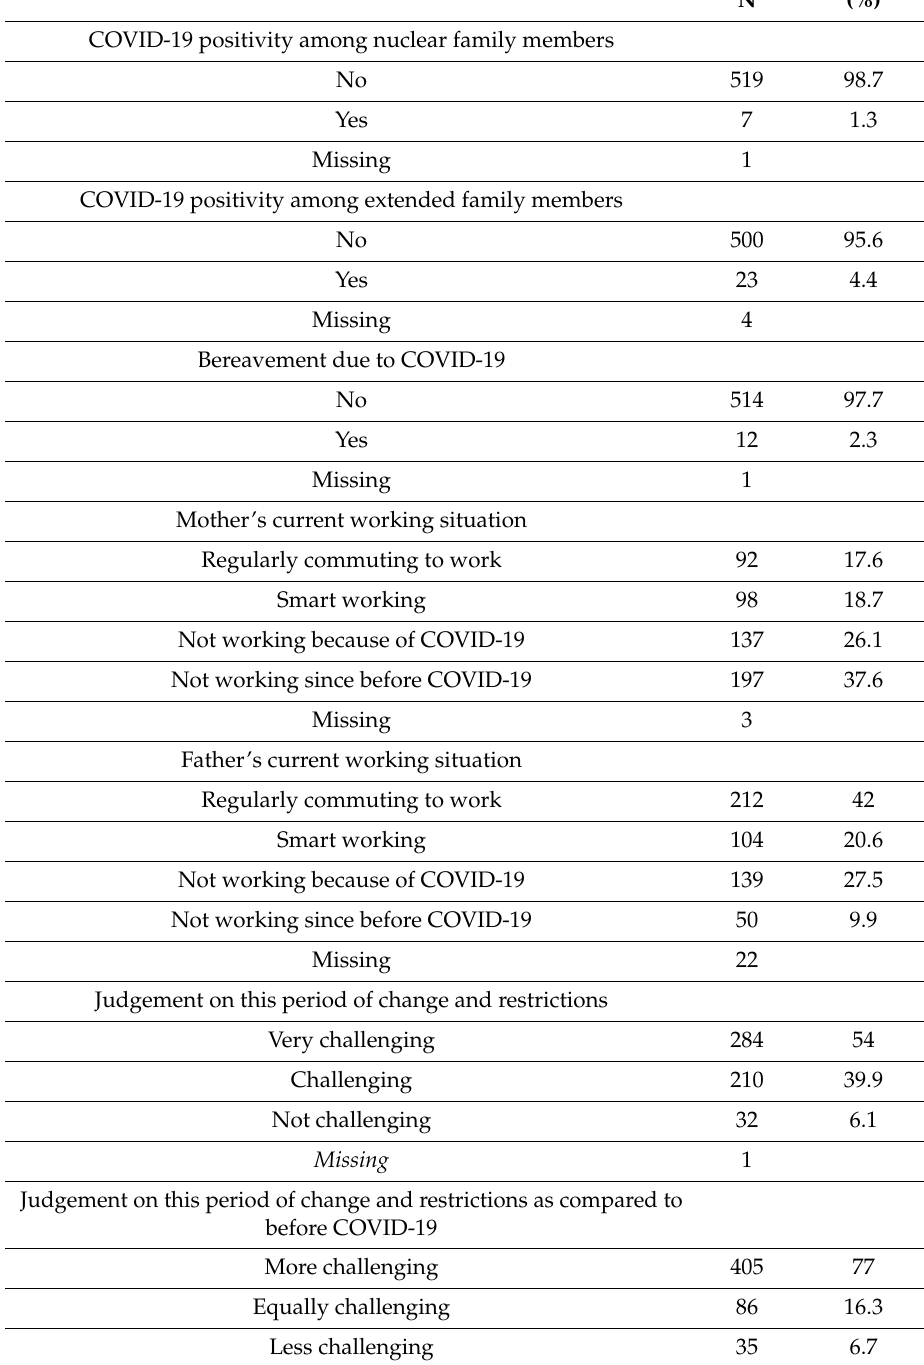
Table 2. Psychosocial and behavioral impact of the emergency